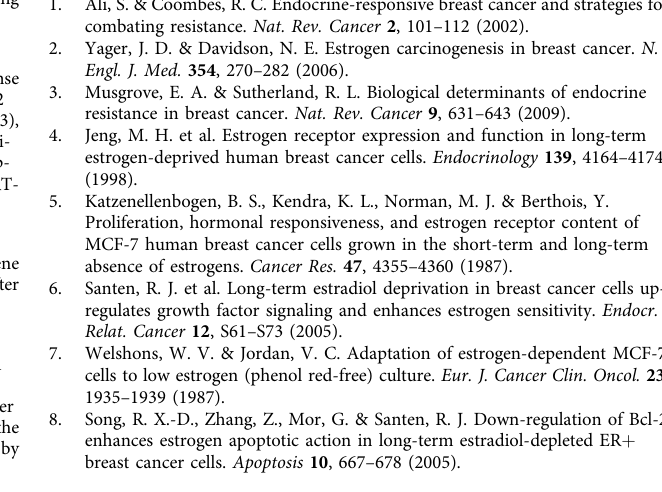
Table 5. BAC DNA was prepared using a large-construct DNA Isolation Kit (Qiagen). Fluorescence in situ hybridization . DNA FISH was performed as follows. Cells grown on coverslips were fi xed with 4% formaldehyde and 0.5% Triton X-100 in PBS for 15min and then permeabilized with 0.5% saponin and 0.5% Triton X-100 in PBS for 20min. Samples were immersed in 20% glycerol in PBS for 30 min and subjected to four cycles of freeze – thawing by freezing the cells in liquid nitrogen for 30s each time and then thawing at room temperature. The cells were then treated with 0.1 N HCl for 15min. For denaturation and hybridization, the cells were incubated in hybridization mixtures (2× SSC, 50% formamide, 10% dextran sul- fate, 1mg/mL tRNA, and 5 – 10 μ g/mL probe DNA) at 75°C for 4 – 10min (for denaturation of genomic DNA) and then at 37 °C for 48 – 72 h (for hybridization). For RNA FISH, the same protocol was used, except for the genomic DNA dena- turation step. BAC probes were labeled with biotin or digoxigenin in a nick translation mixture (Roche), according to the manufacturer ’ s protocol. After hybridization, the cells were washed with 2 × SSC and 50% formamide at 37 °C for 5min, followed by 2× SSC at 37 °C for 5min. FISH signals were detected with fl uorescein isothiocyanate-anti-digoxigenin (Roche) or Cy3-streptavidin (Jackson ImmunoResearch). DNA was counterstained with 4,6-diamidino-2-phenylindole. Microscopic and image analysis . FISH images were obtained using an IX-71 microscope (Olympus) equipped with a 60 ×NA1.0 Plan Apo objective lens, a cooled CCD camera (Hamamatsu), and image acquisition software (Lumina Vision Version 2.4; Mitani Corporation). For comparison of the effects of resveratrol, small interfering RNA (siRNA), and LNA treatments, identical image capture conditions were used within a set of experiments. Image stacks of 3D data sets were collected at 0.5 – 1.0- μ m intervals through the z axis, subjected to projections. The signal intensity of RNA FISH was analyzed using a Cellomics CellInsight with HCS studio cell analysis software (Thermo Fisher Scienti fi c). FISH images in Fig. 2b were obtained with a confocal laser-scanning microscope (LSM 780, Carl Zeiss) equipped with ×63/1.4 Plan-Apochrome objective lens and a cooled CCD camera (Carl Zeiss). Images were acquired